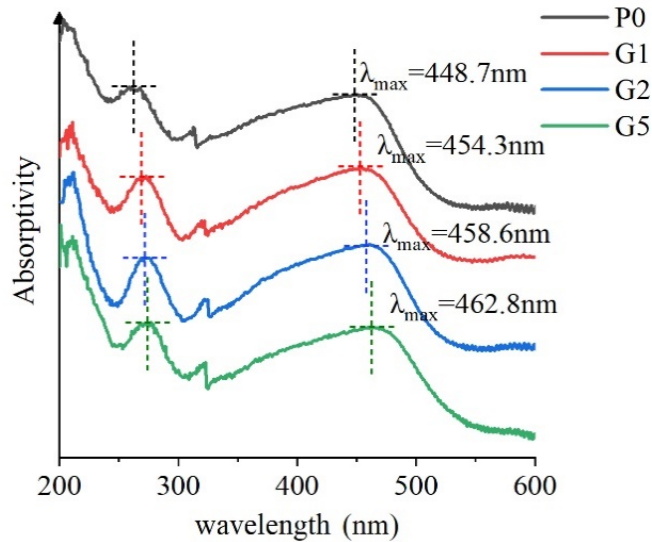
Figure 4. Ultraviolet visible absorption spectrum.